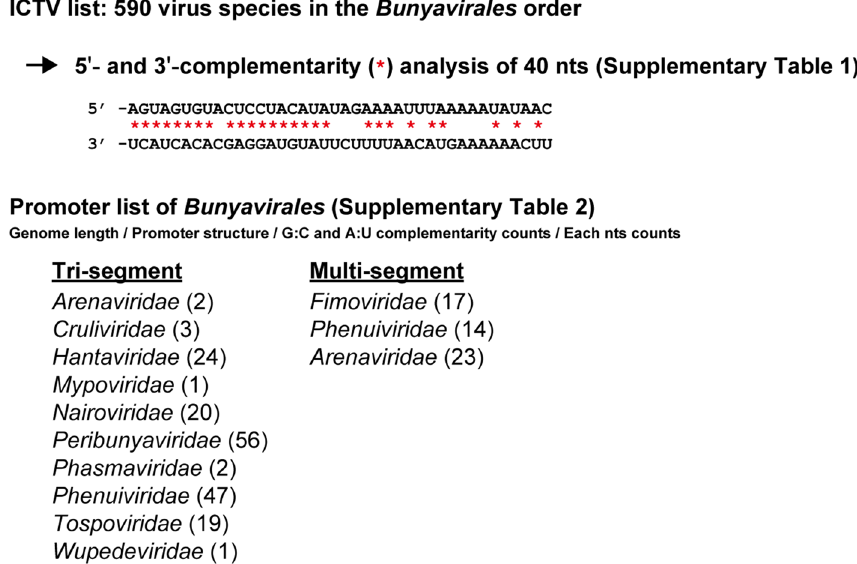
Figure 1. Construction of the promoter list of bunyaviruses. A schematic diagram of the promoter list construction. The promoter structure of 590 species of bunyaviruses registered in the ICTV list was analyzed. The genome length, promoter structure, G:C and A:U complementarity counts, and each nt (A, U, G, and C) count in the 40 nts of the promoters in the genomic ends are listed in Supplementary Table 2. The calculations were performed in an Excel file using automatic calculations for the promoter region as described in Supplementary Table